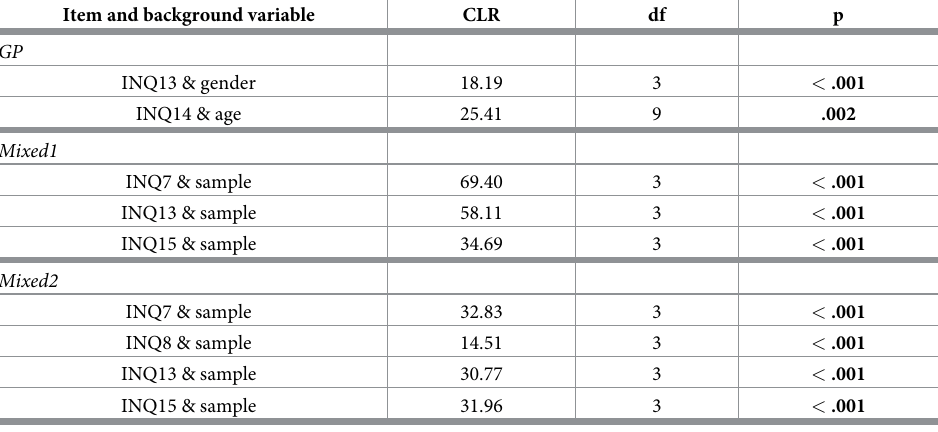
Furthermore, LD between two pairs of items was observed: items INQ7 and INQ8 (“These days, I feel like I belong”), and items INQ13 and INQ14 (“These days, I am close to other peo- ple”) (see Table 7). The item INQ14 was the only item exhibiting misfit (see S7 Table in the S1 Material). After accounting for these departures related to DIF and LD, fit to a GLLRM was obtained (see Table 5). Although DIF related to age was found in the global test-of-no-DIF, there was no evidence of additional DIF at the item level. Likewise, there was no indication of additional LD or item misfit (see Fig 2, and S3, S5 and S7 Tables in the S1 Material). Finally, a reliability of .77 and .83 was observed for the clinical sample and the general pop- ulation respectively, as were similar test information target indices for both subgroups of 0.82